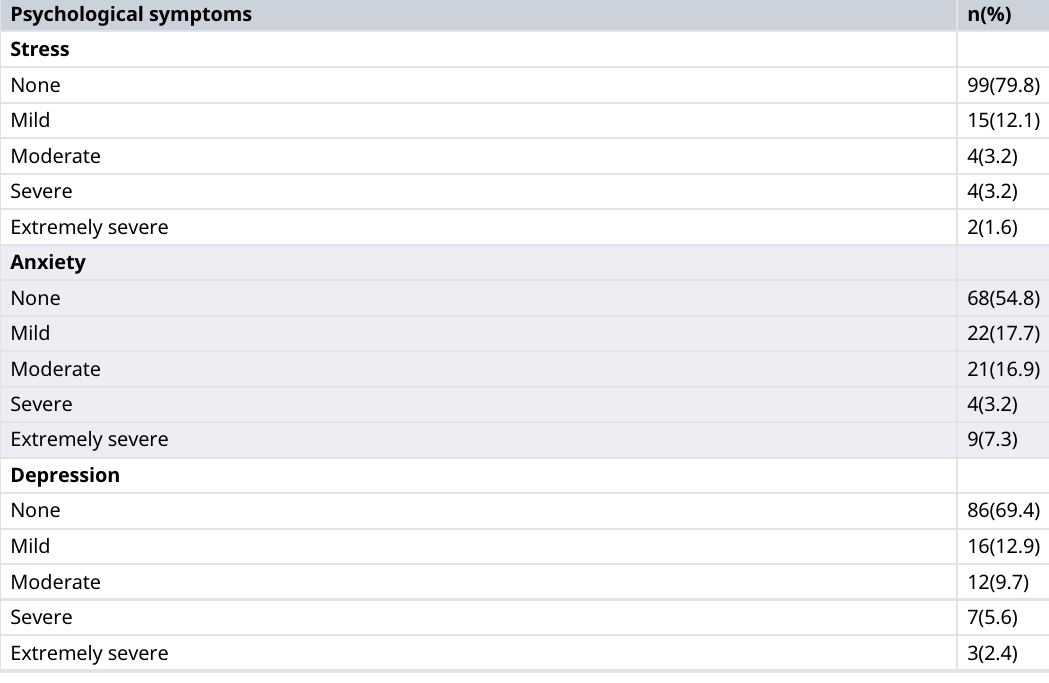
Table 2. Frequency and symptom severity of depression, anxiety and stress levels in